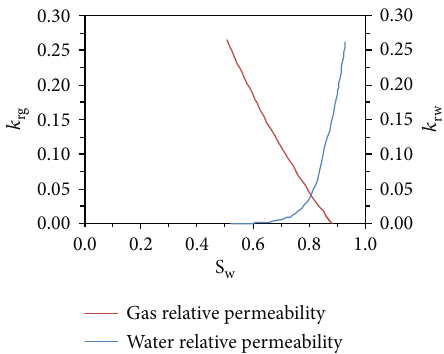
Figure 6: Gas-water relative permeability curve of the cores from Well 3 and Well